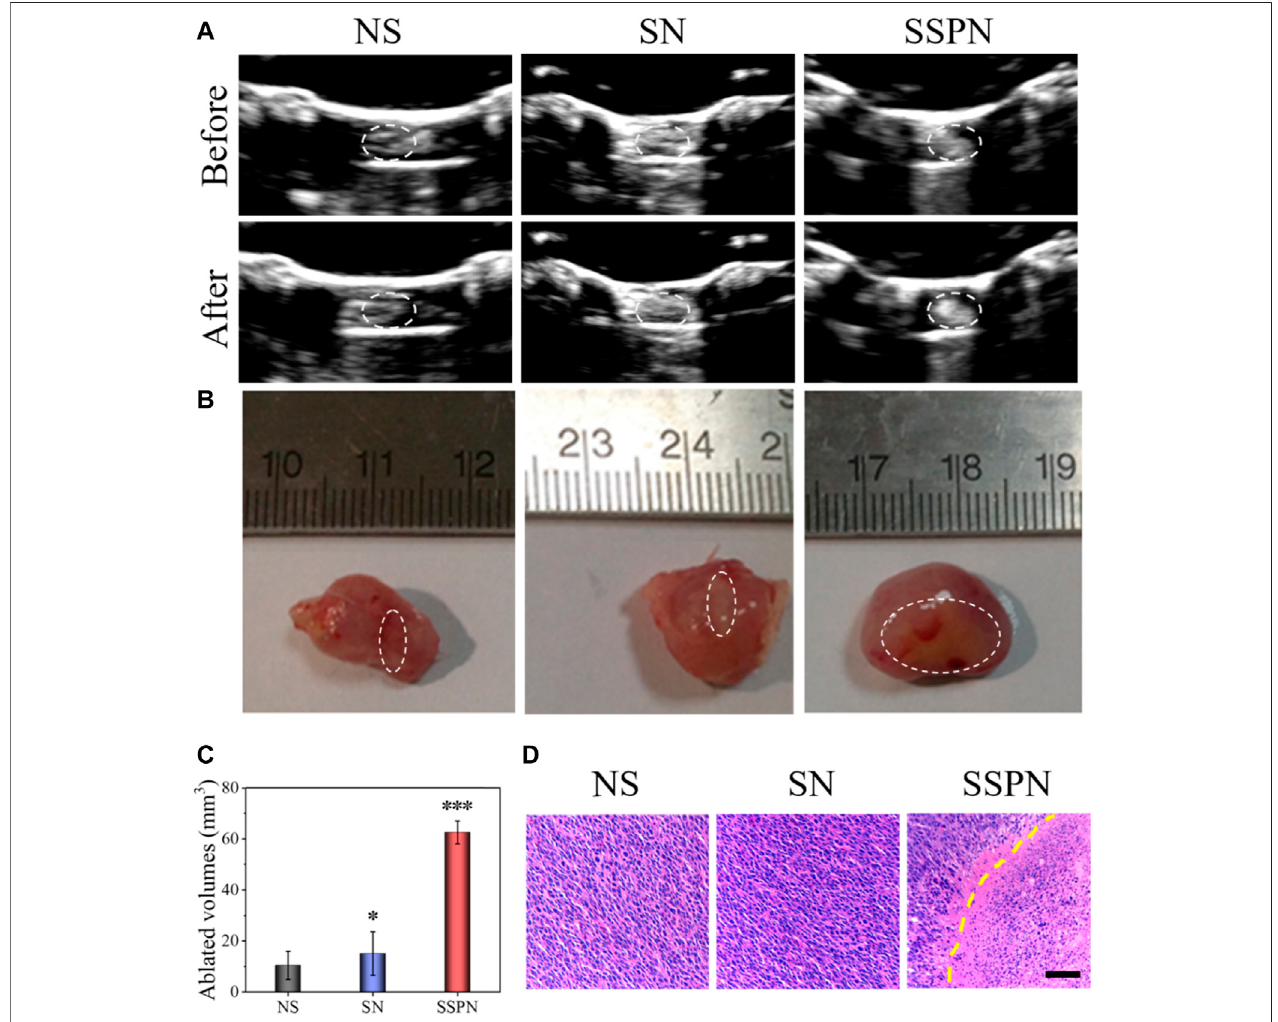
FIGURE6|(A) B-modeultrasoundimagesofNS,SNs, andSSPNs beforeand after HIFUirradiation. (B) Digitalphotos ofablated tumors. (C) Quanti fi cation ofthe corresponding necrotic volume after HIFU irradiation ( n = 3,*** p < 0.001, ** p < 0.01, * p < 0.05). (D) H&E staining of tumor sections after HIFU ablation; images were acquired at 200× magni fi cation (scale bar = 50